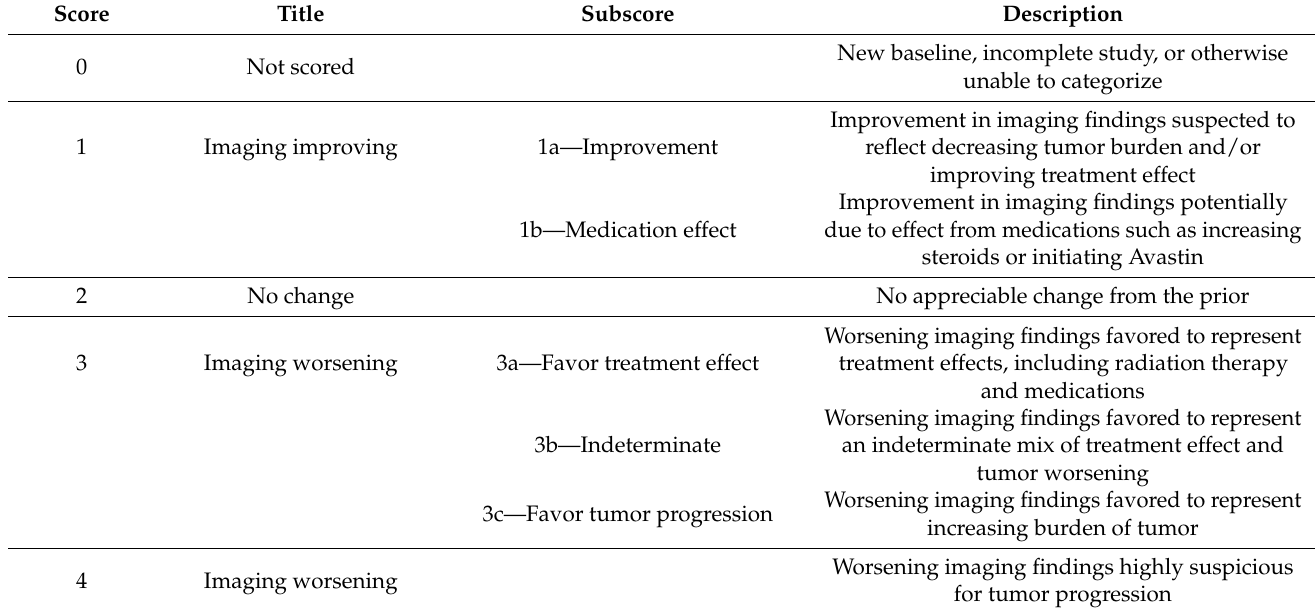
Table 1. BT-RADS Scoring